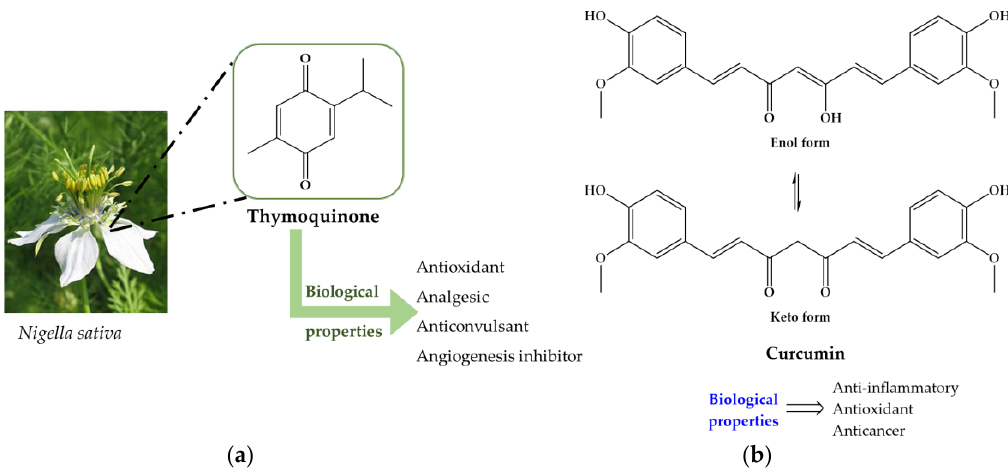
Figure 7. ( a ) Nigella sativa and its therapeutically active constituent, thymoquinone, responsible for diverse biological properties; ( b ) Chemical structures of curcumin and its biological